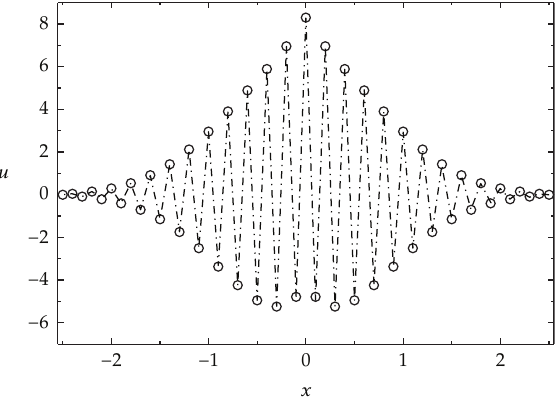
Figure 6: Numerical solution (cid:5) circles (cid:6) provided by our explicit method for the fractional cable equation with γ 1 (cid:7) 0 . 5 and γ 2 (cid:7) 0 . 5 after 100 timesteps when Δ x (cid:7) 1 / 10, Δ t (cid:7) 1 . 3 × 10 − 5 , K (cid:7) μ (cid:7) 1, L (cid:7) 5, and S (cid:7) (cid:5)Δ t (cid:6) γ / (cid:5)Δ x (cid:6) 2 (cid:7) 0 . 36. Note that this value is larger than the stability limit S × (cid:7) (cid:5) 2 γ 2 − μ 2 (cid:5)Δ t (cid:6) γ 2 (cid:6) / (cid:5) 2 2 (cid:9) γ 2 − γ 1 (cid:6) (cid:3) 0 . 352 ... provided by (cid:5) 3.7 (cid:6) . The broken line is to guide the